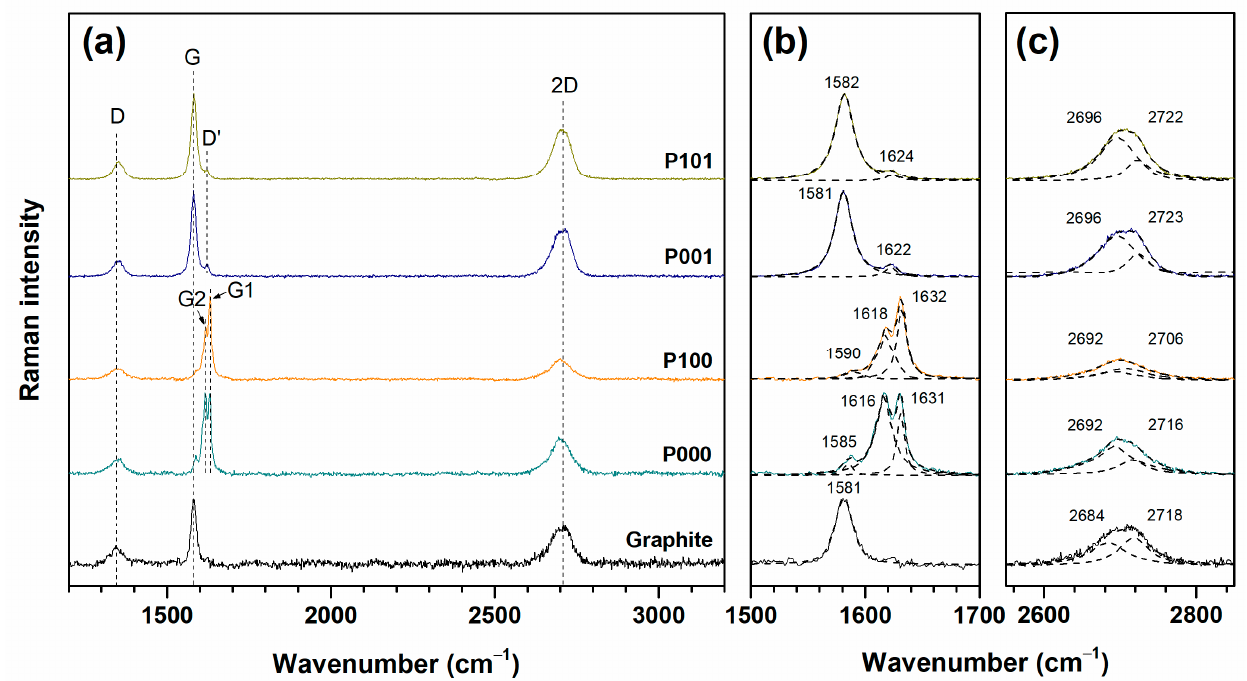
Figure 4. Raman spectra of GBS products obtained using K 2 S 2 O 8 oxidizing agent ( a ), G band frequencies ( b ), and 2D band frequencies ( c ).